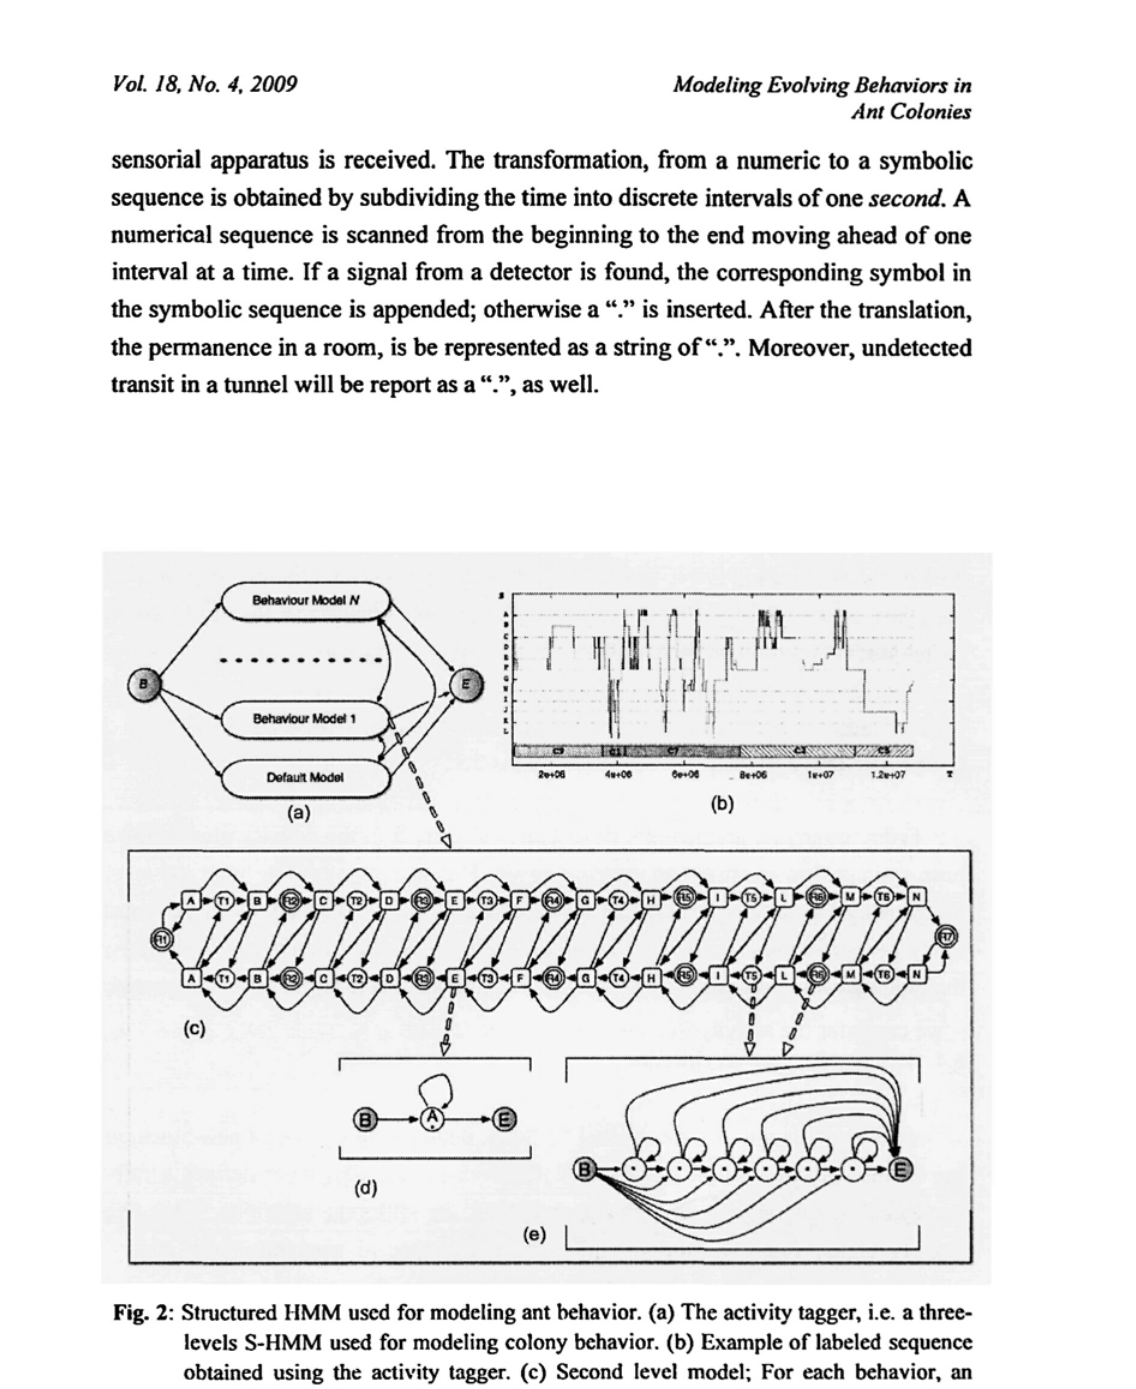
Fig. 2: Structured HMM used for modeling ant behavior, (a) The activity tagger, i.e. a three- levels S-HMM used for modeling colony behavior, (b) Example of labeled sequence obtained using the activity tagger, (c) Second level model; For each behavior, an independent model has been learned, (b) basic block encoding the passage under a sensor; (c) basic block modeling the duration of the permanence in a room or a